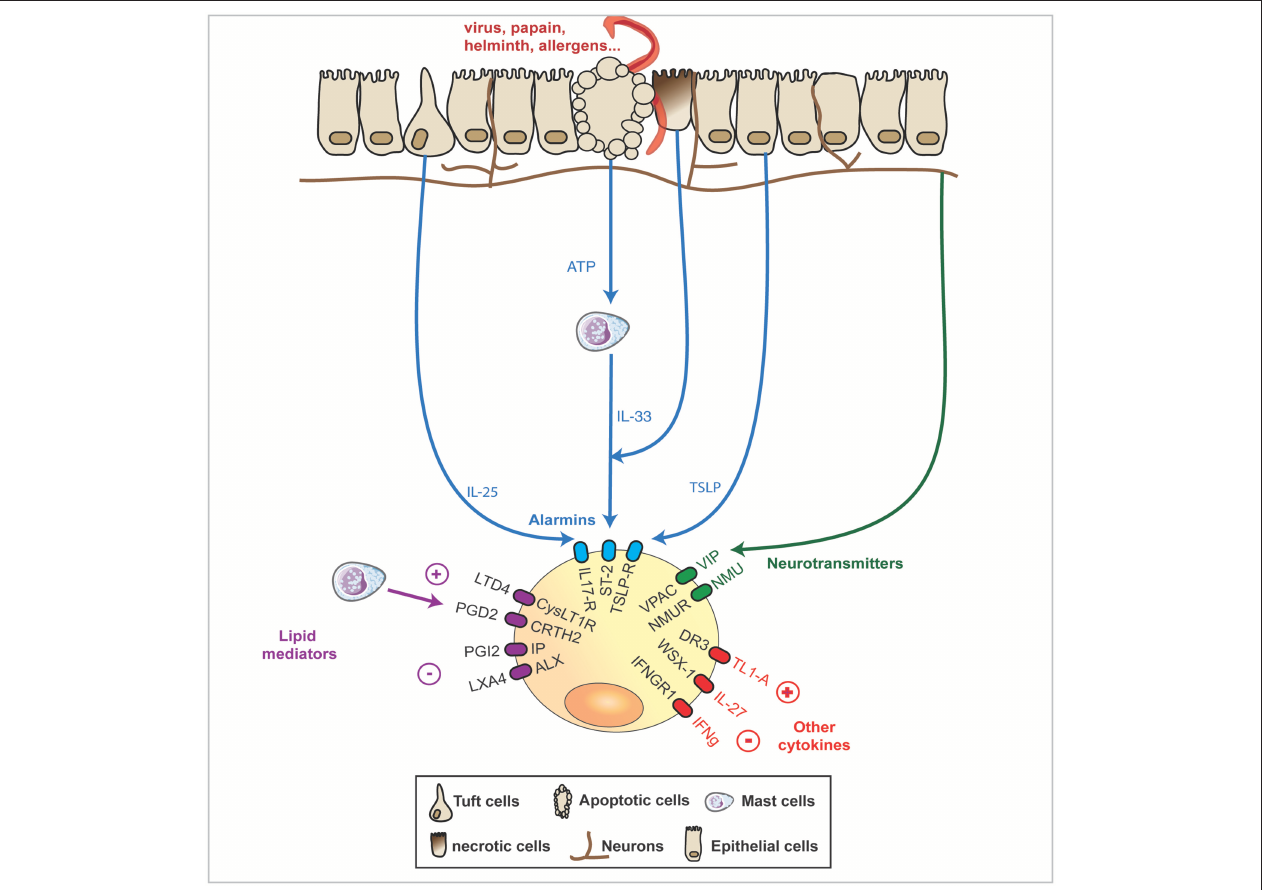
FIGURE 1 | In response to various stimuli such as infection or injury, mucosal epithelial barriers express a range of signals that ILC2s can integrate. The most studied and thought to be of utmost importance pathway of activation of ILC2 is formed by the “alarmins,” IL-33, TSLP, and IL-25 that cause release of the canonical IL-13, IL-5, and amphiregulin cytokines expression. Upon damage, necrotic epithelial cells can release IL-33 while apoptotic epithelial cells, can release ATP, that further activates mast cells to release IL-33. Alternatively, epithelial cells can release TSLP or the newly identified and specialized chemosensory epithelial cells, namely tuft cells, can release IL-25. Recently mucosal sensory nervous system has been shown to detect helminths and protists and release in response Neuromedin (Nmu) or vasoactive intestinal polypeptide (VIP) that can both activates by themselves ILC2s or synergise with alarmins to potentiate ILC2 response. Finally, some cytokines and lipid mediators have emerged as potential controllers of ILC2s, with the prostaglandin PGI2 and the lipoxin LXA4 limiting ILC2 cytokines release, while the prostaglandin PGD2 and the leukotriene LTD4 can potentiate the same cytokine expression. The regulatory IL-27 cytokines as well as Interferon (IFN)g can dampen ILC2